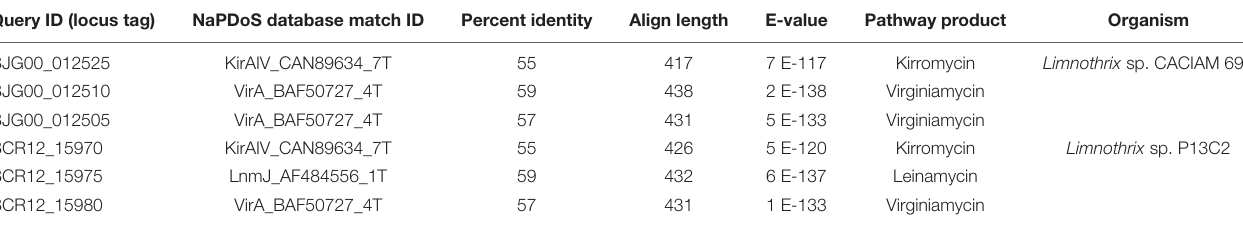
TABLE 4 | NaPDoS results for KS domain containing proteins present in trans -AT PKS clusters found in Limnothrix sp. CACIAM 69d and Limnothrix sp. P13C2. Query ID (locus